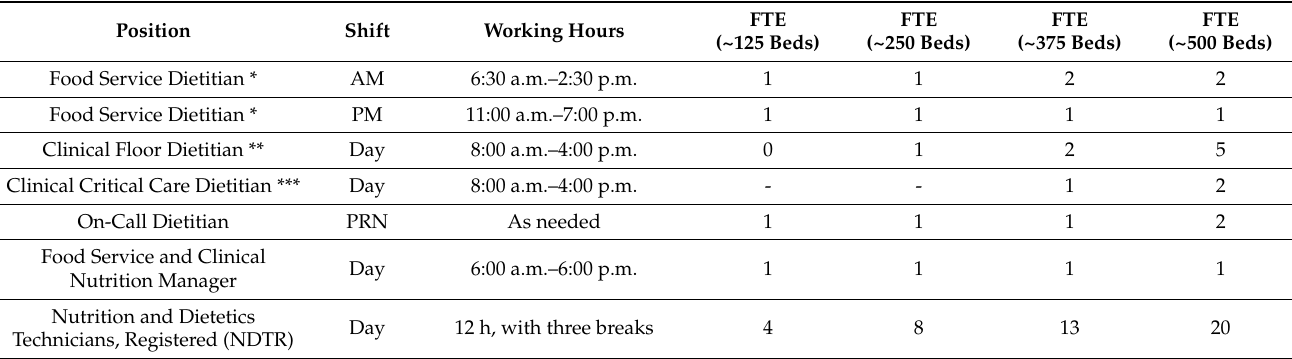
Table 5. The field hospital staffing model is designed to identify staffing needs for nutrition services in a field hospital setting with 125–500 patient